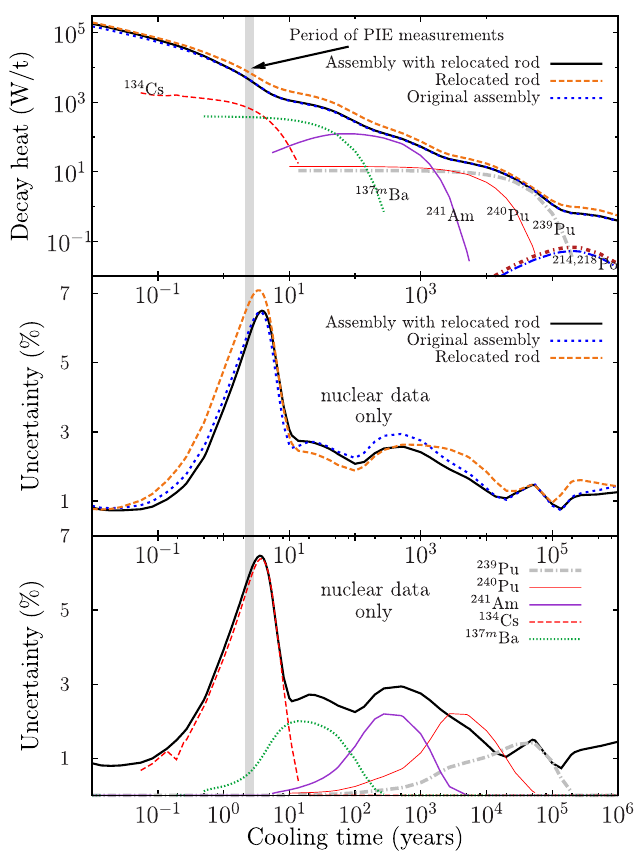
Fig. 8. Calculated decay heats for the assembly (with and without relocation) hosting the GU3 sample and the relocated rod (top); uncertainties due to nuclear data (middle and bot- tom figures), with the ENDF/B-VIII.0 library. The five most important contributors for the uncertainties are also